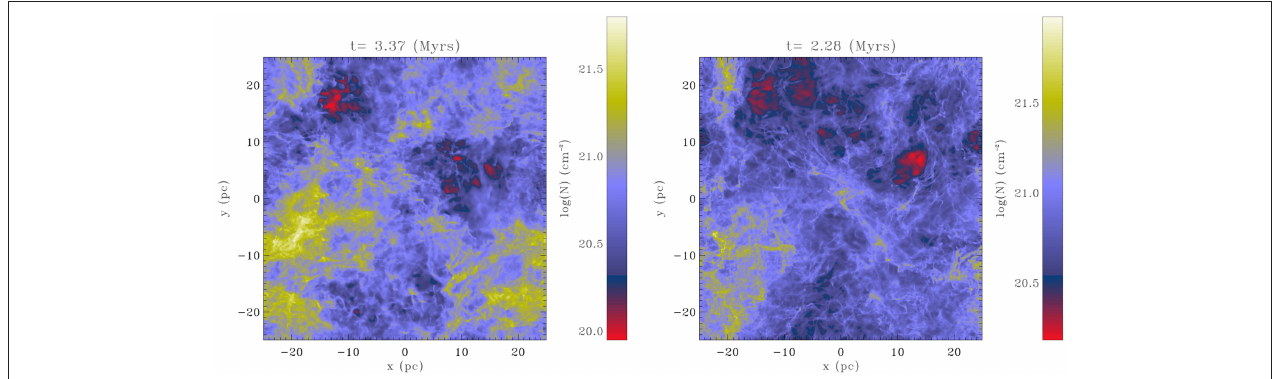
FIGURE 9 | Column density for one snapshot of a decaying turbulence experiment. Left hydrodynamical run, right MHD run (from Hennebelle, 2013). Initially the field is uniform and has an intensity of 5 µ G. The magnetized run presents a more filamentary structure that the hydrodynamical run as can seen through visual inspection and confirmed by detailed analysis (see Figure 10 ). Reproduced from Hennebelle (2013) with permission of A&A.